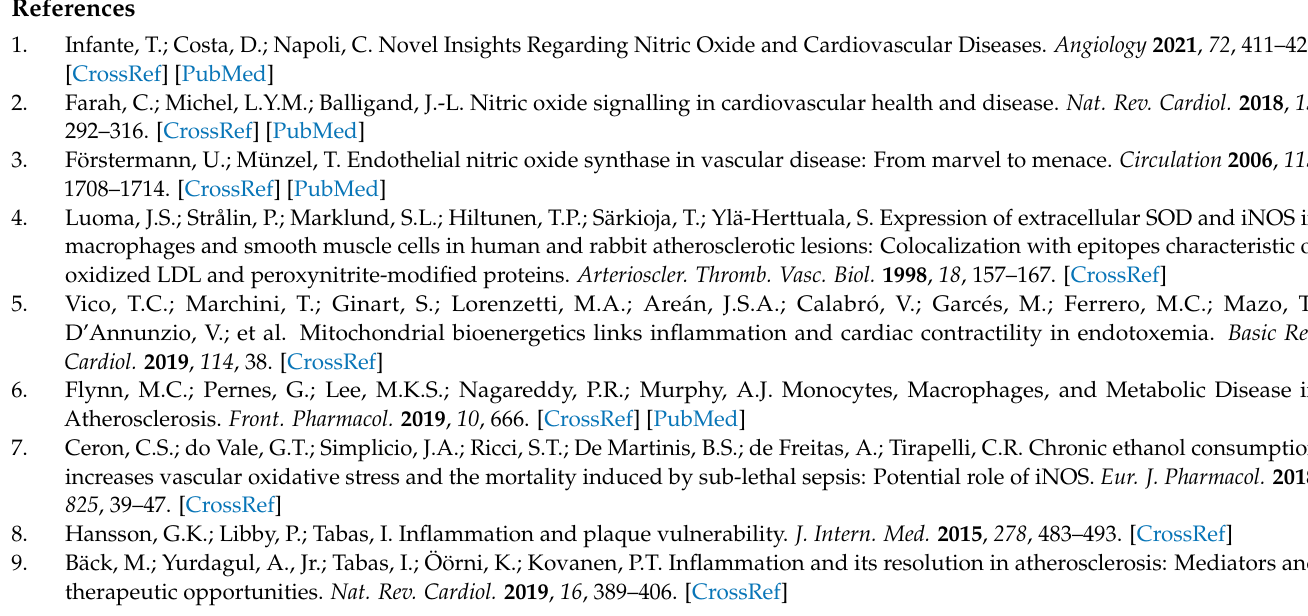
Figure S4: Ex vivo uptake of Ru-NO by macrophages in liver cell suspensions from atherosclerotic mice. Figure S5: Ex vivo uptake of Ru-NO by macrophages in spleen cell suspensions from atheroscle- rotic mice. Table S1: Demographic and Clinical information of patient blood samples for the analyses with the Ru-NO